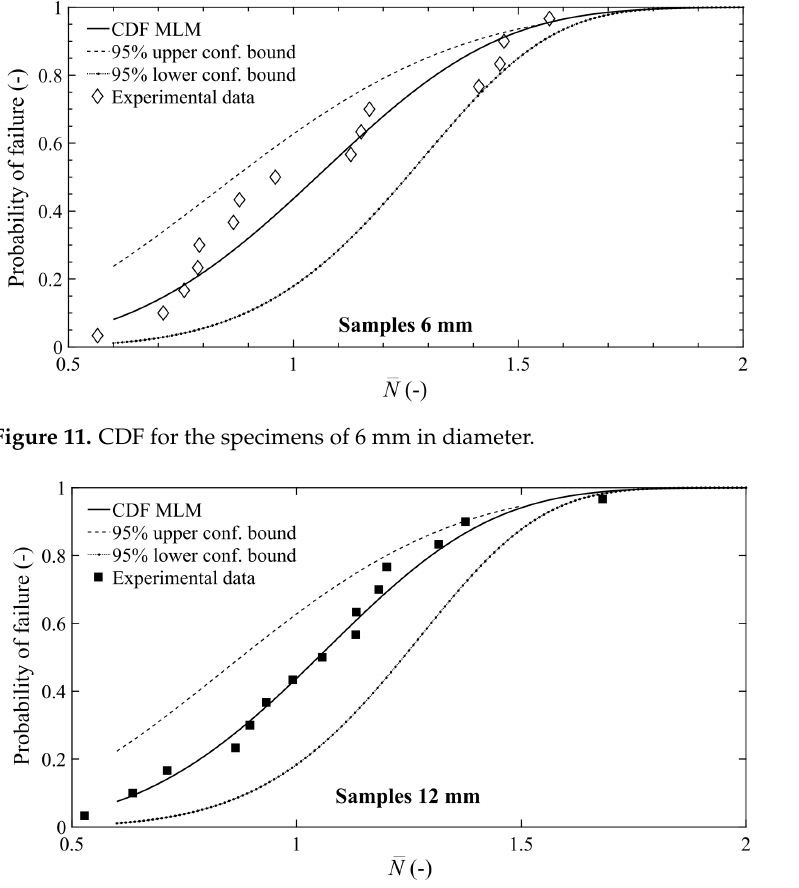
Figure 12. CDF for the specimens of 12 mm in diameter.